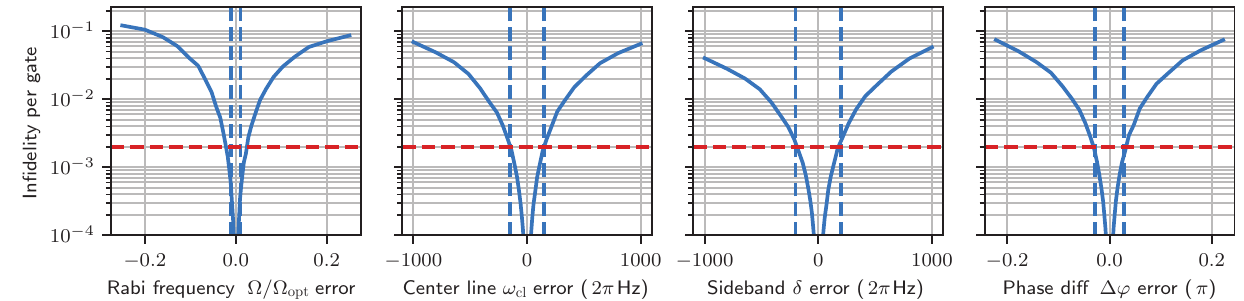
FIG. 5. Expected randomized benchmarking infidelity as a function of individual parameter miscalibrations for a 100 μ s gate. These curves inform the choice of target thresholds (blue dashed lines); an infidelity of 2 × 10 − 3 (red dashed line) for each parameter has been chosen as a threshold. The fixed parameters are kept at (cid:8) = (cid:8) opt , ω cl = 0, δ = 10 × 2 π kHz, (cid:13)φ = 0.